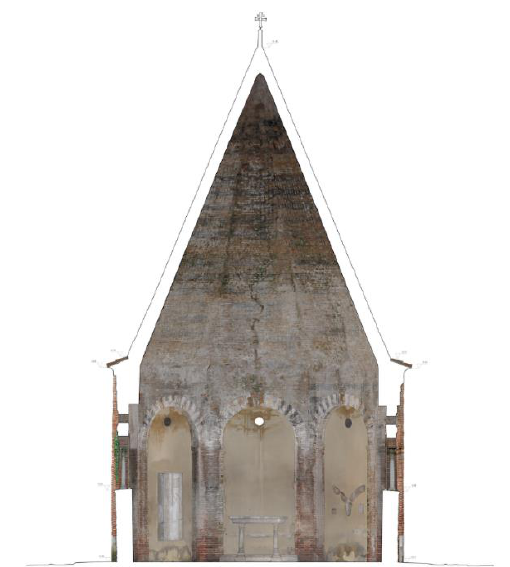
Figure 11. Example of the surey final drawings: vertical section (originale scale 1:25)